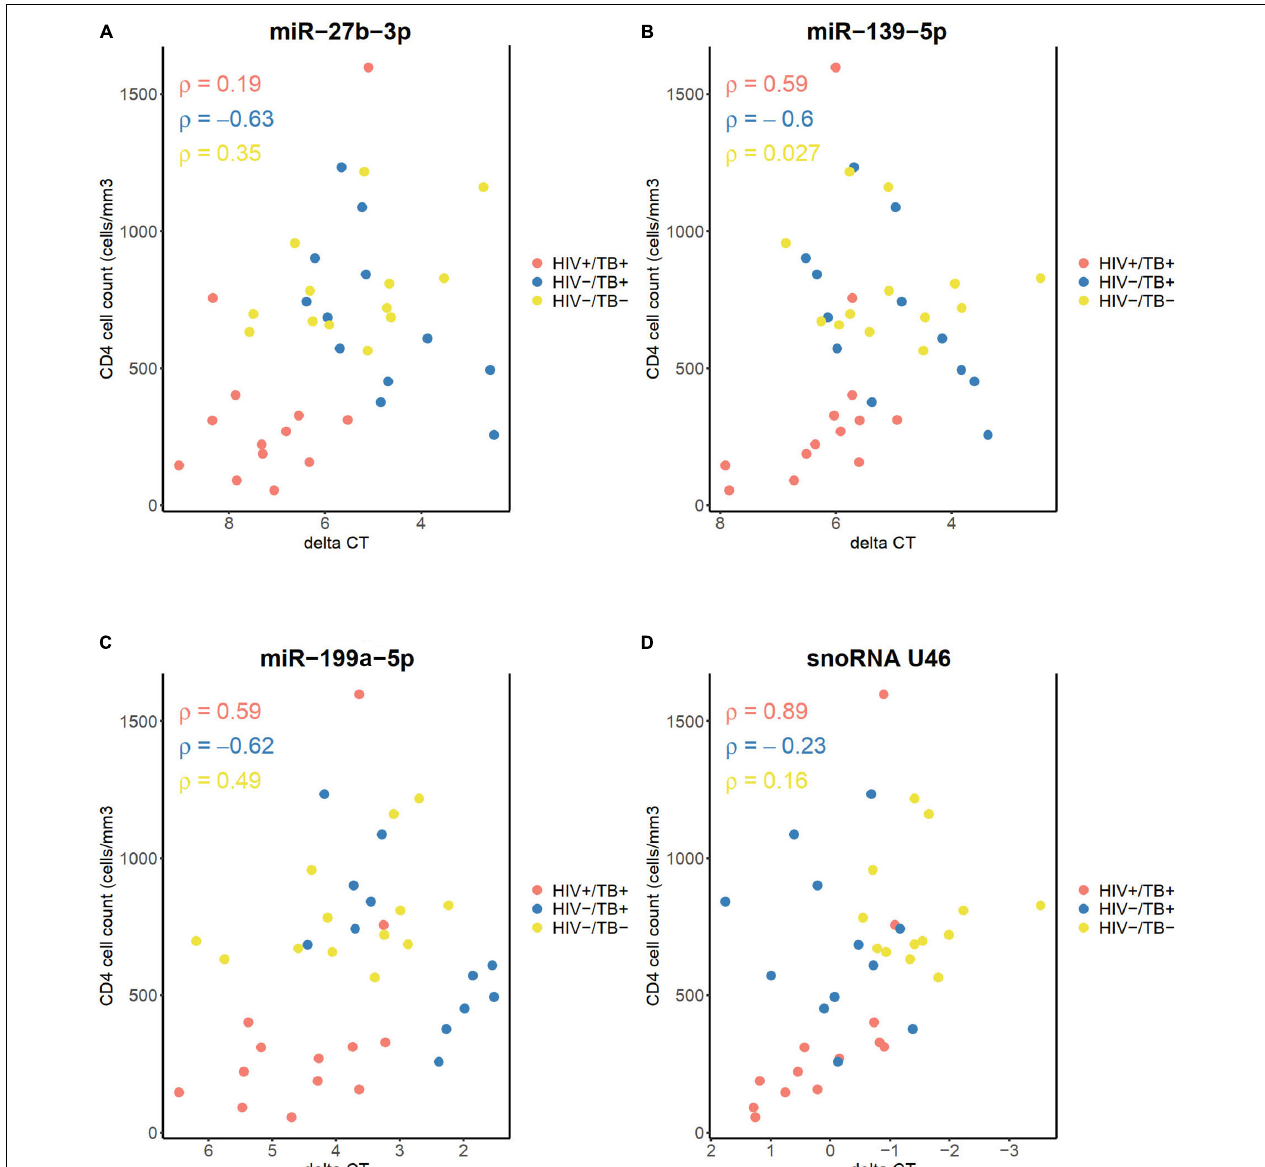
FIGURE 7 | Correlation between CD4 + cell count before treatment, and the levels of (A) miR-27b-3p, (B) miR-139-5p, (C) miR-199a-5p, and (D) snoRNA U46, measured by qPCR. Infection status is represented by color, HIV+/TB+ (red), HIV-/TB+ (blue) and HIV-/TB- (yellow). Spearman’s rho is indicated for each group in the matching